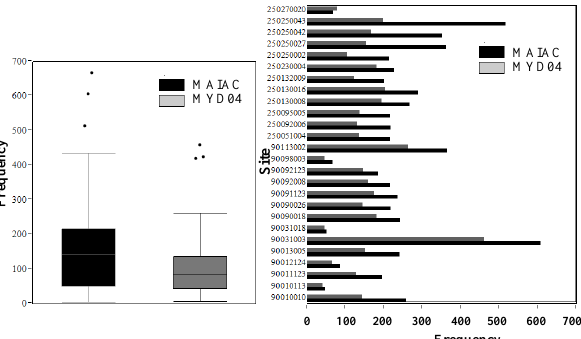
Fig. 7. Left: frequency distribution of the number of collocated AOD–PM 2 . 5 pairs at 85 EPA ground monitoring stations for MA- IAC (black box) and for MYD04 (grey box) during the period 4 July 2002–29 December 2008 in New England. Right: the same as left but for representative EPA sites located in MA and